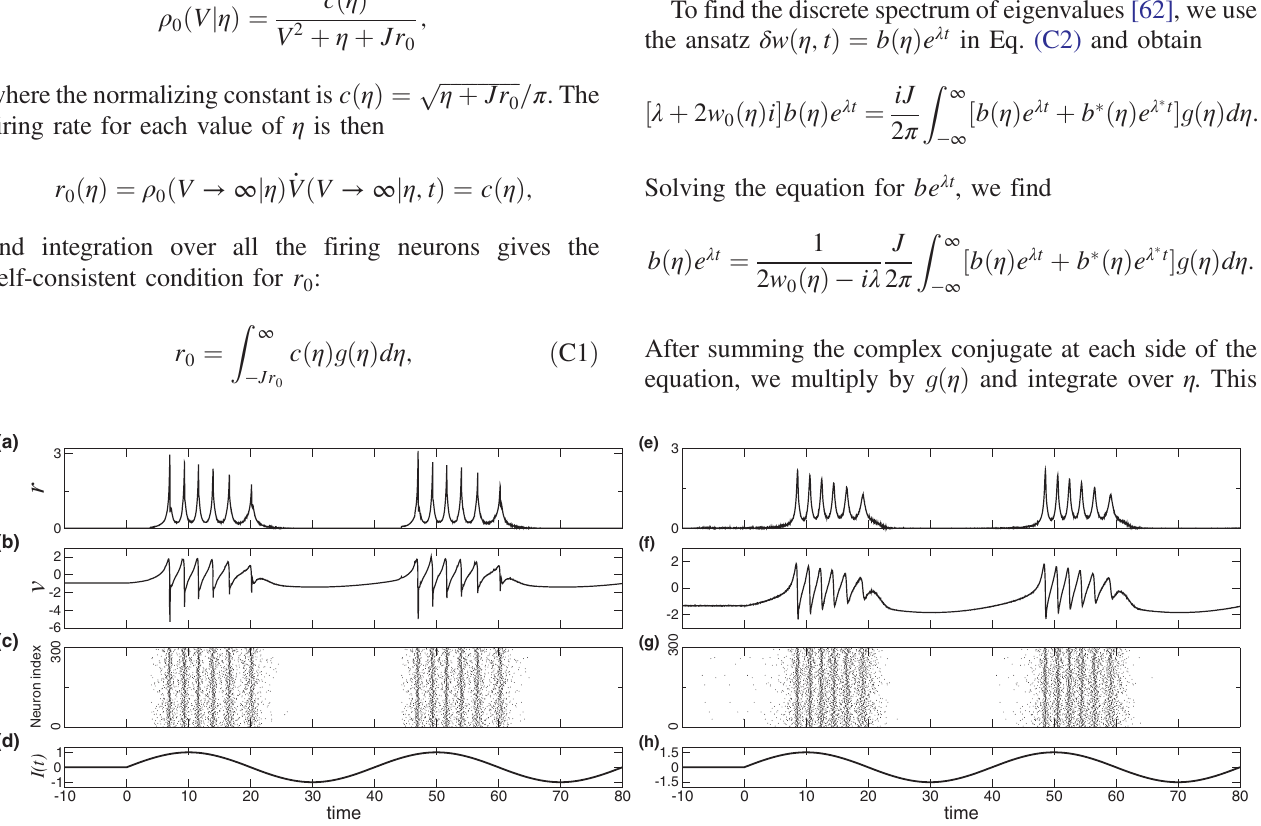
FIG. 6. Numerical simulations of the excitatory network of QIF neurons, Eqs. (1) and (2). with (a) – (d) uniform and (e) – (h) Gaussian distributions of currents. As in Fig. 2, at time t ¼ 0 , an external sinusoidal current I ð t Þ ¼ I 0 sin ð ω t Þ — shown in (d) and (h) — is applied to all neurons. (a),(e) Time series of the firing rate and (b),(f) the mean membrane potential of all cells. In (c) and (g), we depict the raster plots of 300 randomly chosen neurons. Parameters correspond to the black triangle symbols in Fig. 5: (a) – (d) ¯ η ¼ − 1 , J ¼ 8 , γ ¼ 1 , I 0 ¼ 1 ; (e) – (h) ¯ η ¼ − 2 , J ¼ 10 , σ ¼ 1 , I 0 ¼ 1 . 5